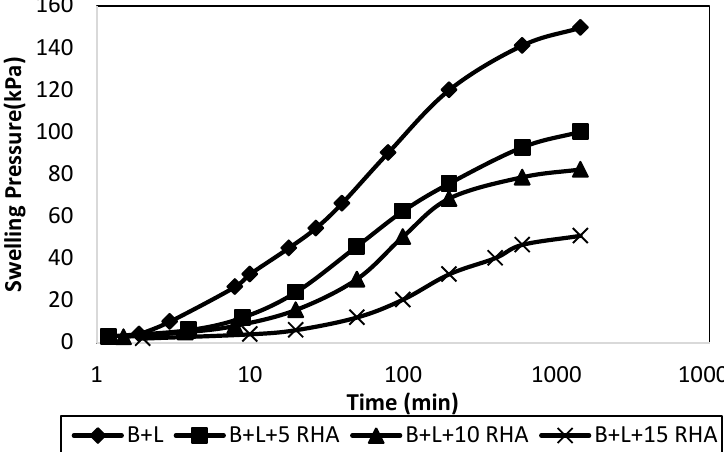
Figure 4. The effect of RHA on swelling pressure of soil stabilized with lime after 7 days of curing